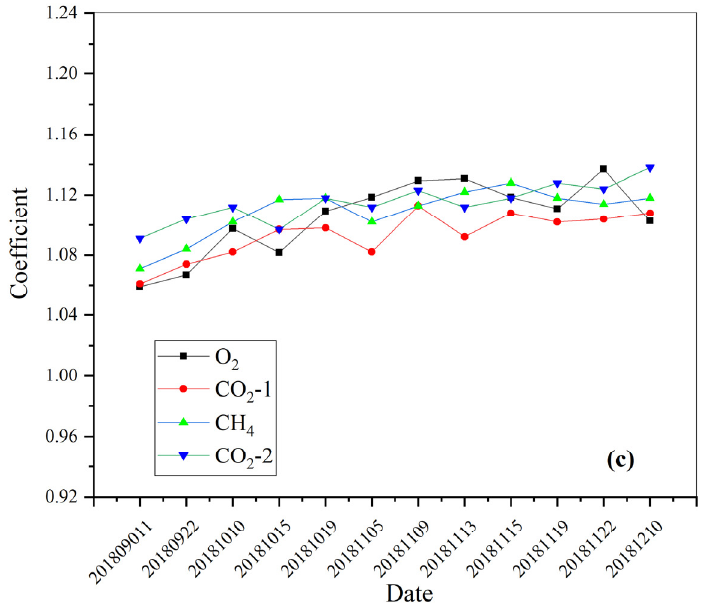
Figure 20. GMI site calibration coefficient results. ( a ) Kufra, Libya, ( b ) Fafara, Egypt 1, ( c ) Arabian Peninsula.